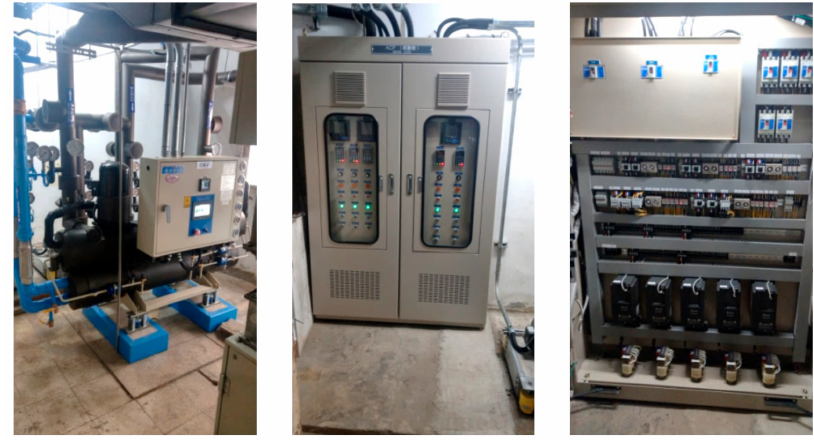
Figure 5. Replacement of air-conditioner and related equipment in